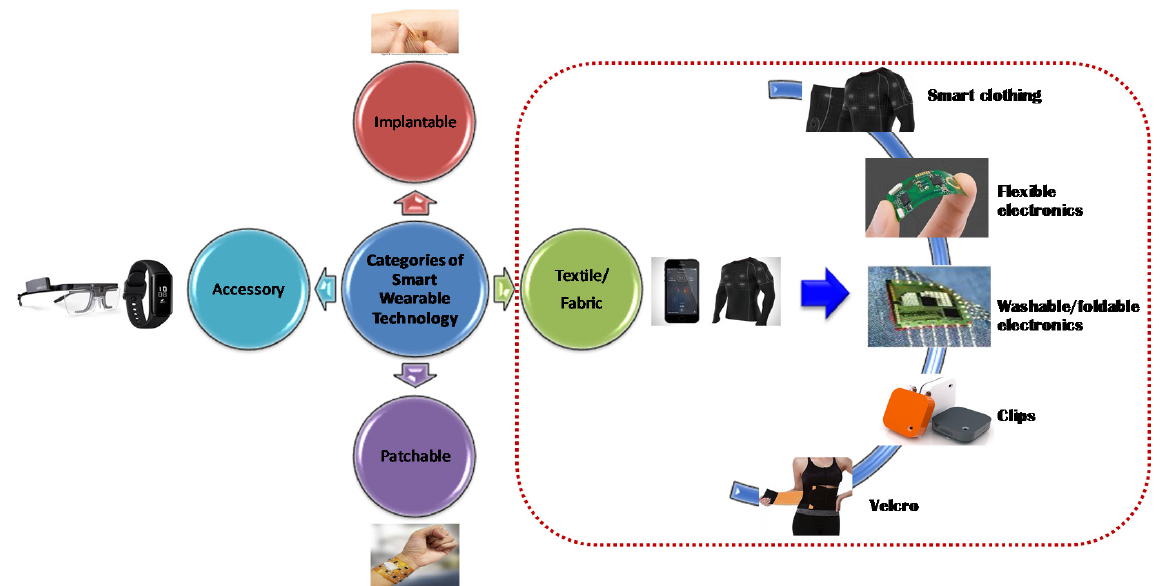
Figure 1. Examples of wearable technology.